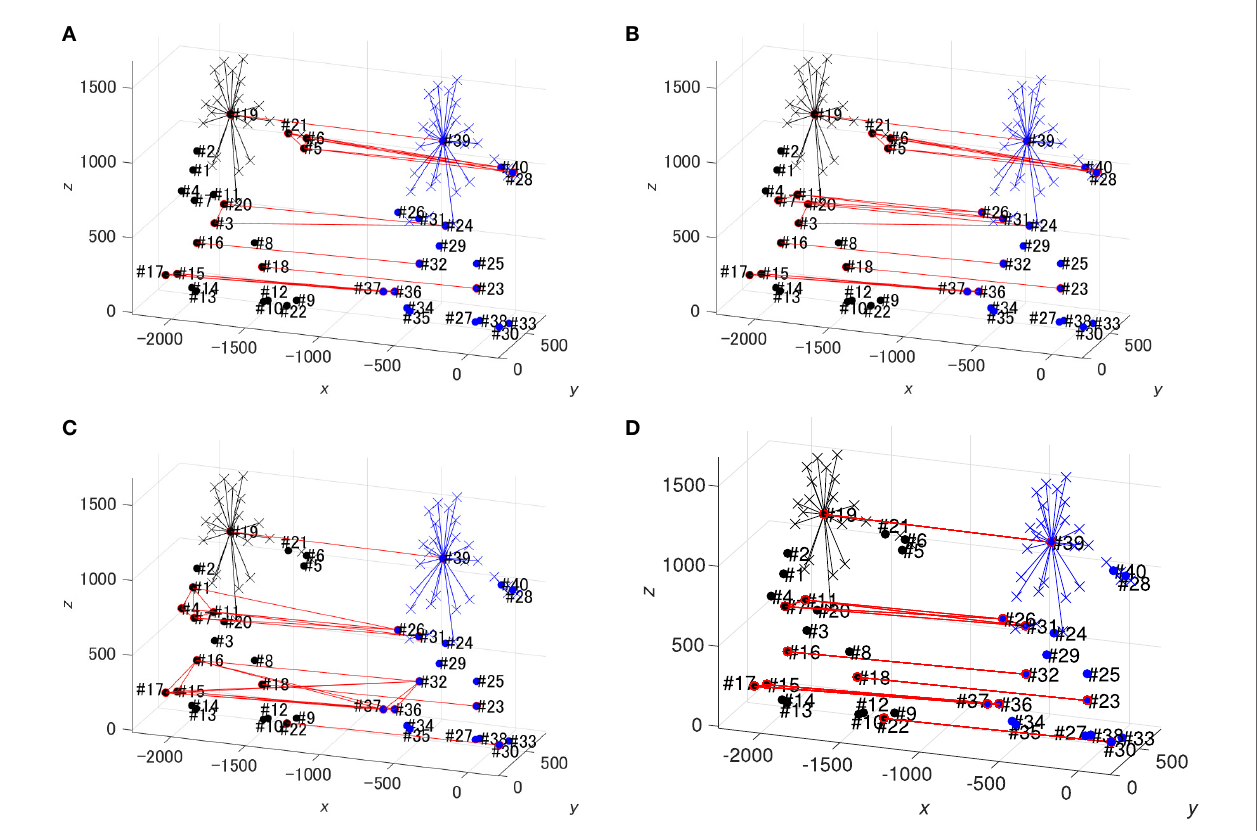
FIGURE 7 | Equivalence structures obtained by ES incremental search: (A) eight-dimensional ES, (B) seven-dimensional ES 1, (C) seven-dimensional ES 2, and (D) seven-dimensional ES 3. Black points and cross marks represent dataset 1 at t = 1, while blue points represent dataset 2 at t = 150. Cross marks represent sequences that were merged in preprocessing. The elements at each position in the tuples are connected with red lines.